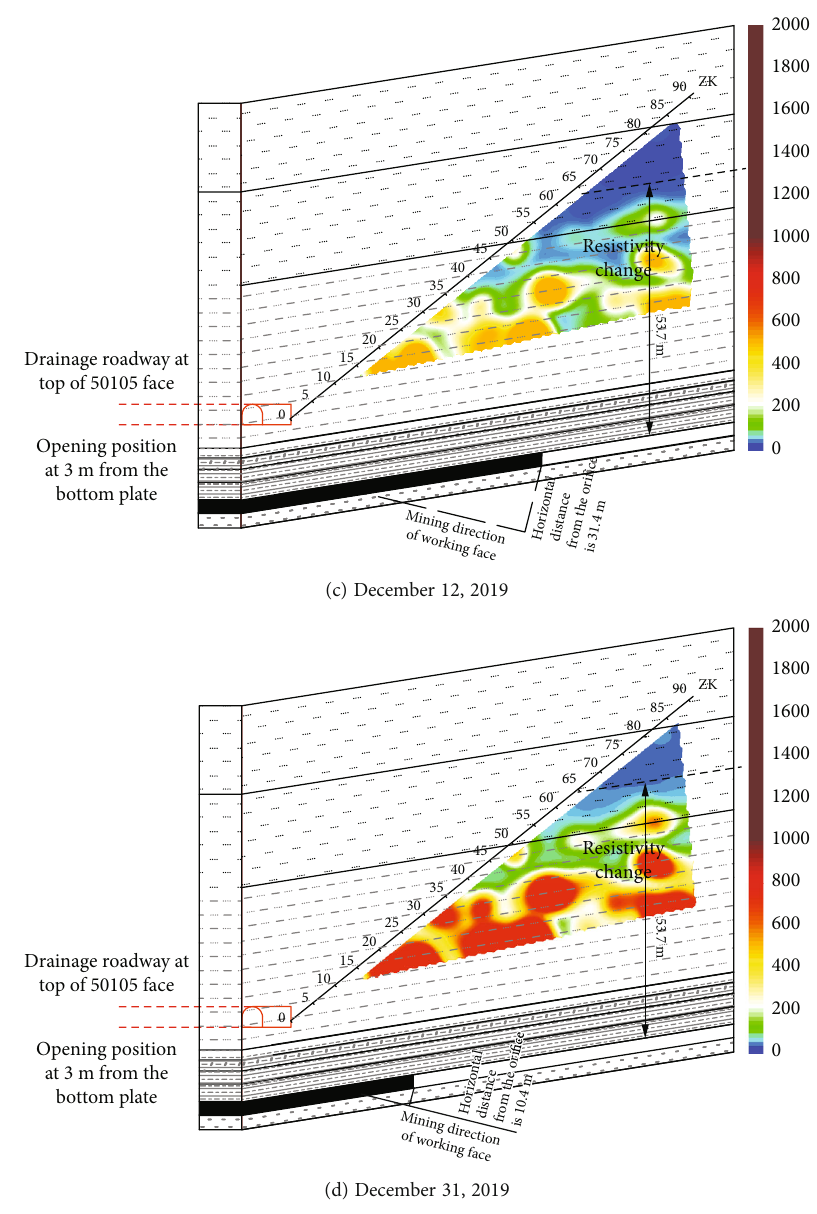
Figure 10: Resistivity observation pro fi le of the 50105 working Table 5: Height of overlying rock fracture development.